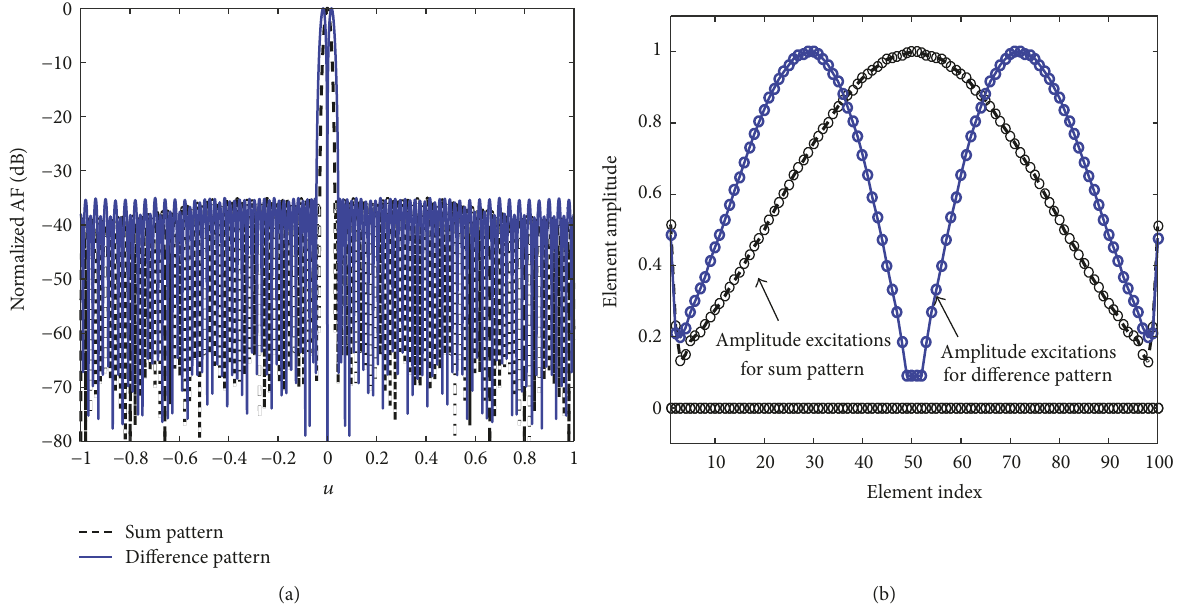
Figure 5: Sum and difference patterns (a) and the corresponding amplitude excitation (b) for the case of no common excitation and 𝑁 = 100